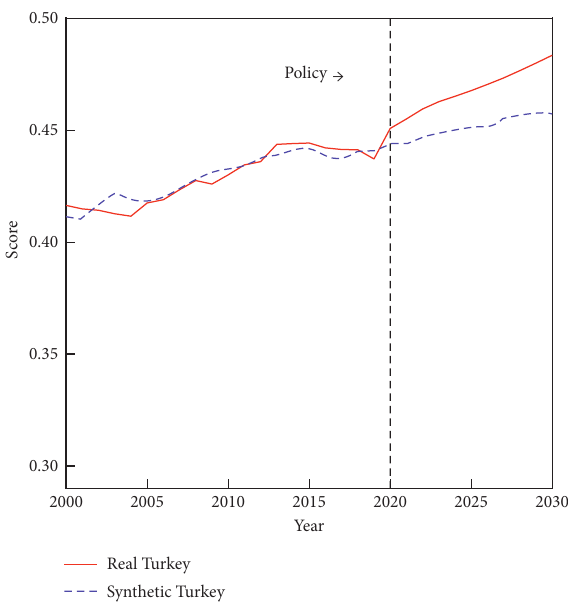
Figure 6: Estimation of policy effect of Turkey’s higher education development plan.